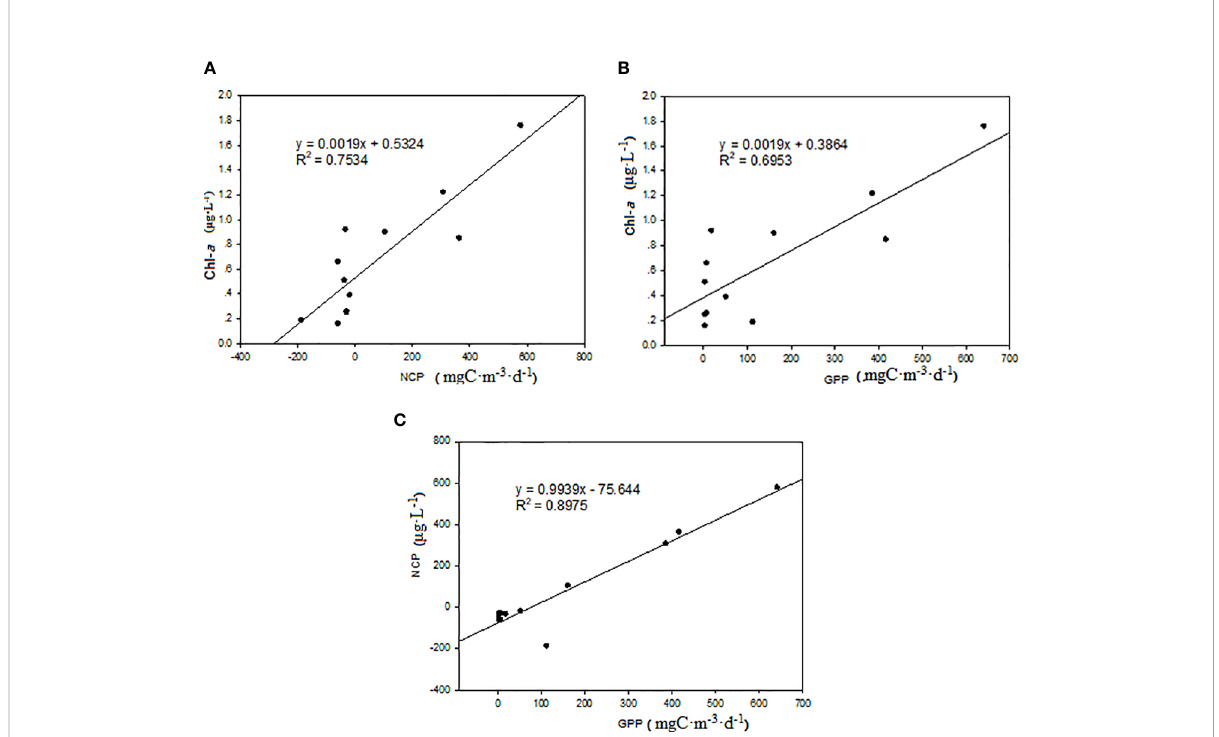
FIGURE 5 Pearson analysis between ecological parameters and environmental factors (A) Chl- a -NCP. (B) Chl- a -GPP. (C) NCP-GPP). Chl- a , chlorophyll a ; GPP, gross primary production; NCP, net community